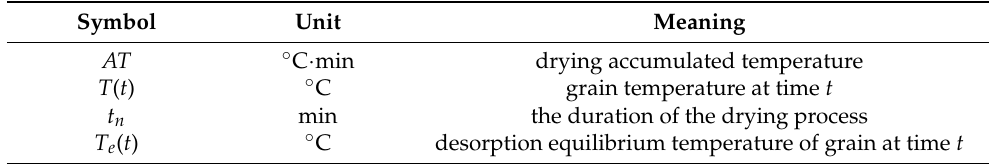
Table 2. Formula (2) symbols and